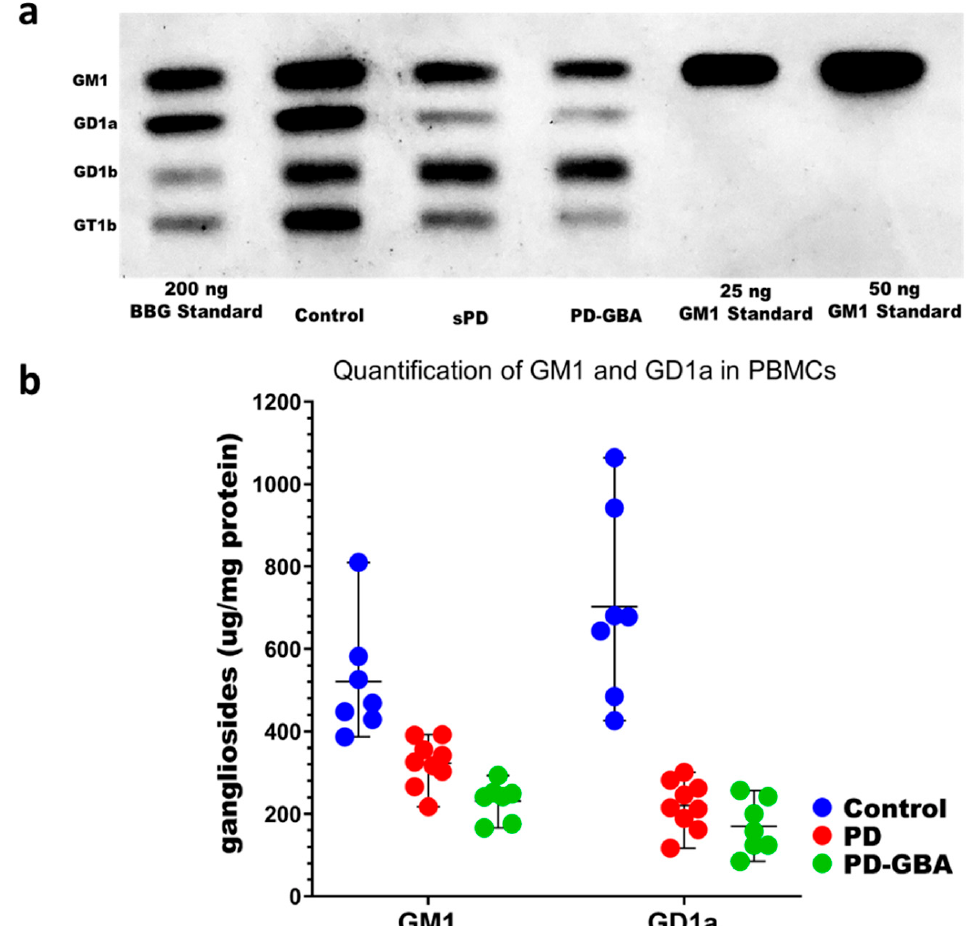
Figure 1. Detection and quantification of GM1 and GD1a in PBMCs. ( a ) Image of autoradiographic film depicting HPTLC separation and CtxB-HRP detection of GM1, GD1a and other ganglio-series following N’ase treatment. ( b ) GM1 and GD1a are shown as the mean and range of levels by upper and lower lines for PBMCs from seven healthy controls, nine sPD, and seven PD-GBA patients. One-way ANOVA revealed a significant difference in GM1 between controls and the other two groups: F(2, 20) = 19.45, p < 0.0001. Tukey’s HSD post-hoc testing revealed that sPD and PD-GBA patients both had significantly less GM1 than healthy controls ( p = 0.0008 and p < 0.0001 resp.). One-way ANOVA revealed a significant difference in GD1a between controls and the other two groups: F(2, 20) = 33.81, p < 0.0001. Tukey’s HSD post-hoc testing revealed that sPD and PD-GBA patients both had significantly less GD1a than healthy controls ( p < 0.0001 for both). Additionally, PD-GBA patients had lower amount of GM1 ( p = 0.13) and GD1a ( p = 0.74) compared to sPD patients, though these were not